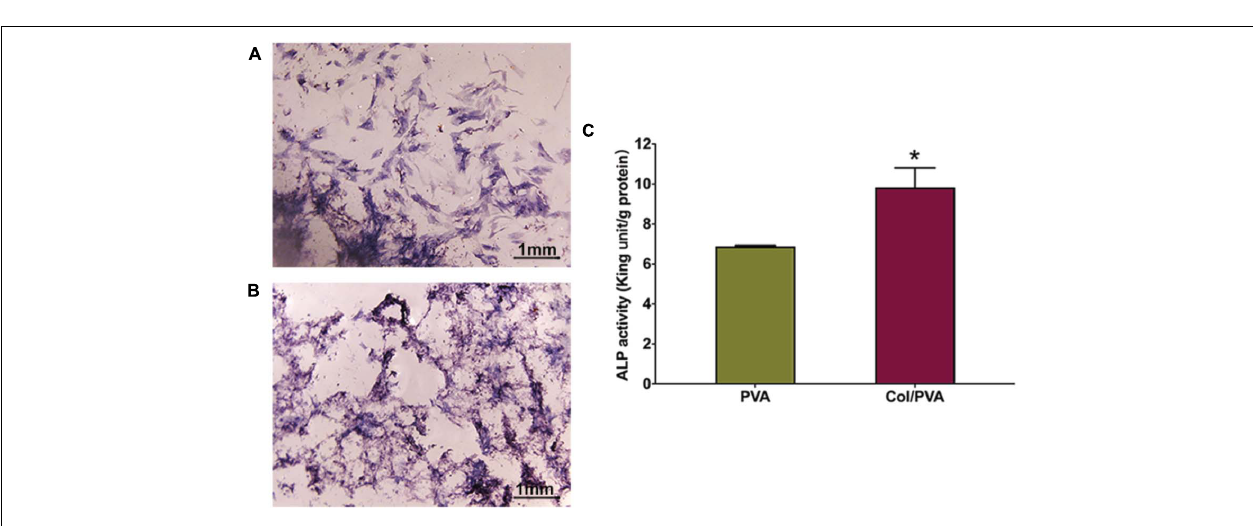
FIGURE 8 | The ALP staining images of BMSCs cultured on the (A) pure PVA membrane and (B) the collagen layer of the Col/PVA dual-layer membrane for 7 days. (C) ALP activity of BMSCs cultured on the different surfaces for 7 days. *indicates a significant difference between PVA and Col/PVA group with p -value <